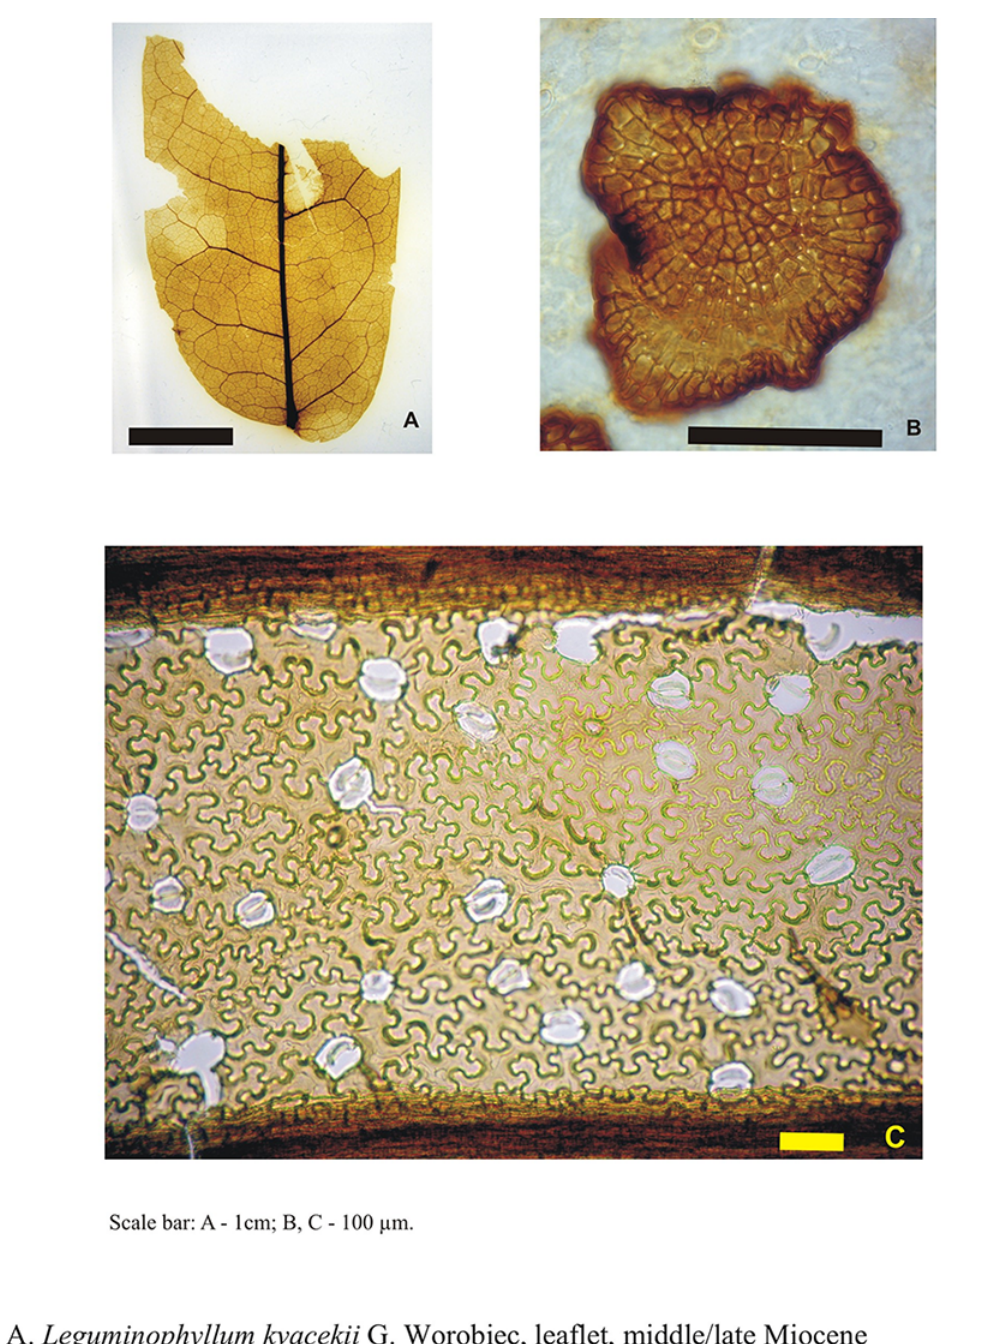
Figure 3 Macro and microremains of plants and fungi from the Polish Miocene. Photo: G.